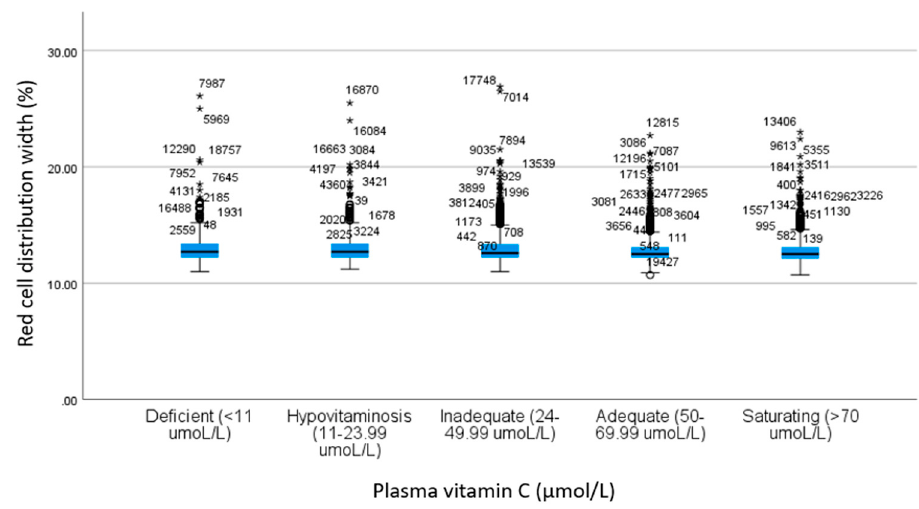
Figure 2. Participant RDW mean levels in plasma vitamin C categories. * denotes participant outlier.